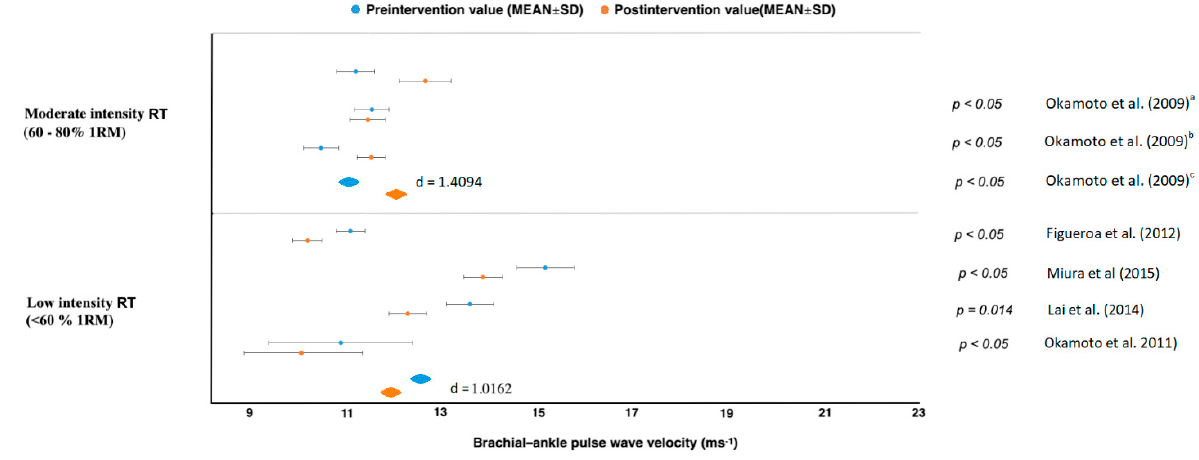
Figure 5. Brachial–ankle pulse wave velocity changes. a upper limb training group, b lower limb training group, c group of resistance training with slow lifting and quick lowering.